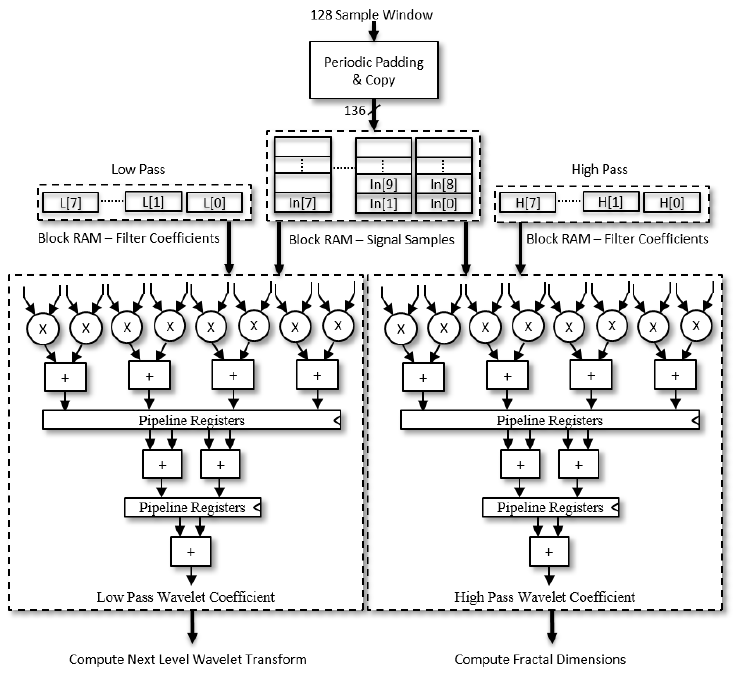
Figure 7. Hardware arithmetic pipeline of wavelet